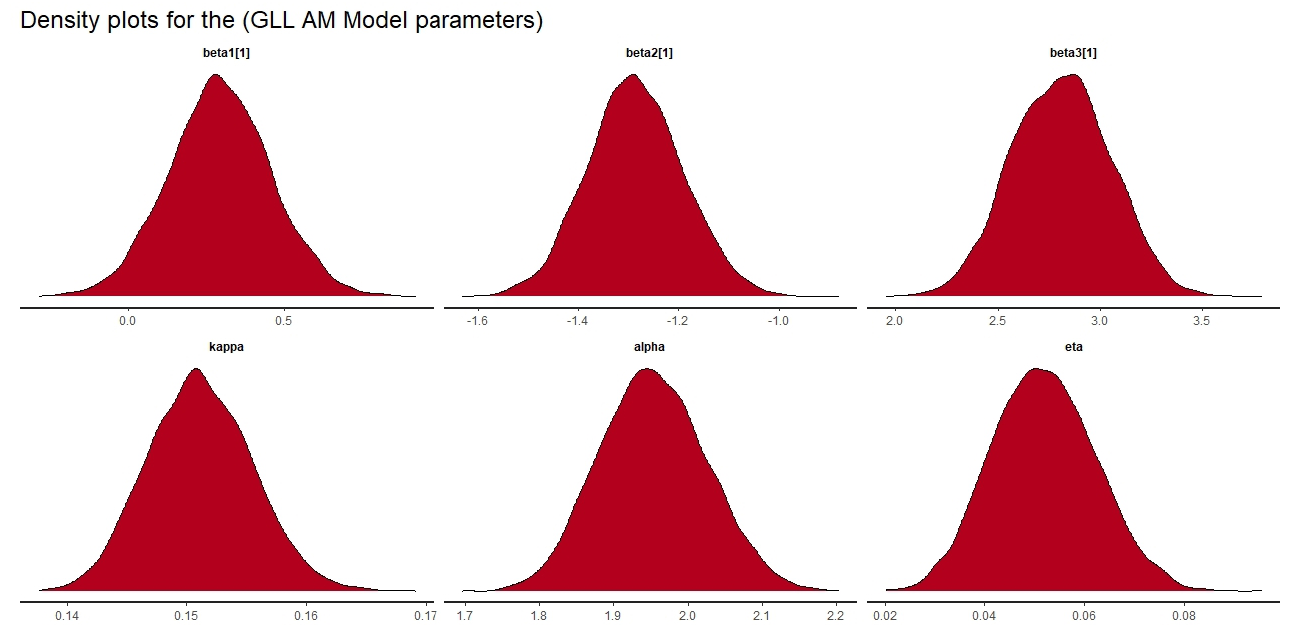
Figure 14. Density plots for the GLL − AM model parameters.